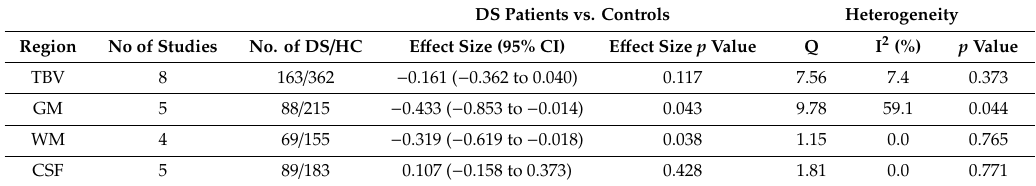
Table 2. Meta-analysis of continuous data comparing patients with DS vs. healthy controls (HC).